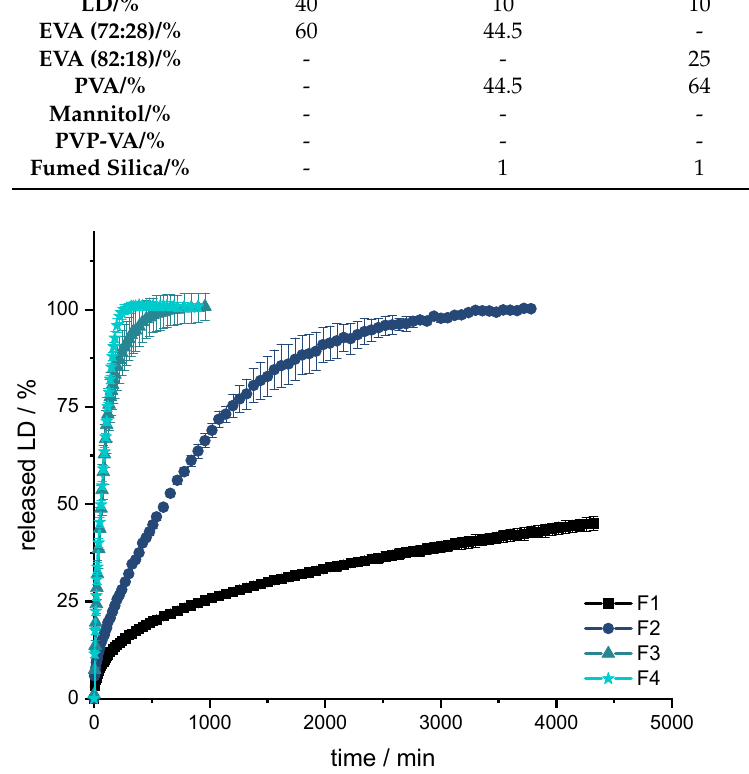
Figure 4. Dissolution of LD from F1, F2, F3 and F4; modified basket apparatus, 1000 mL 0.1 N HCl, 50 rpm, 37.0 ± 0.5 °C. x ± s; n = 3.